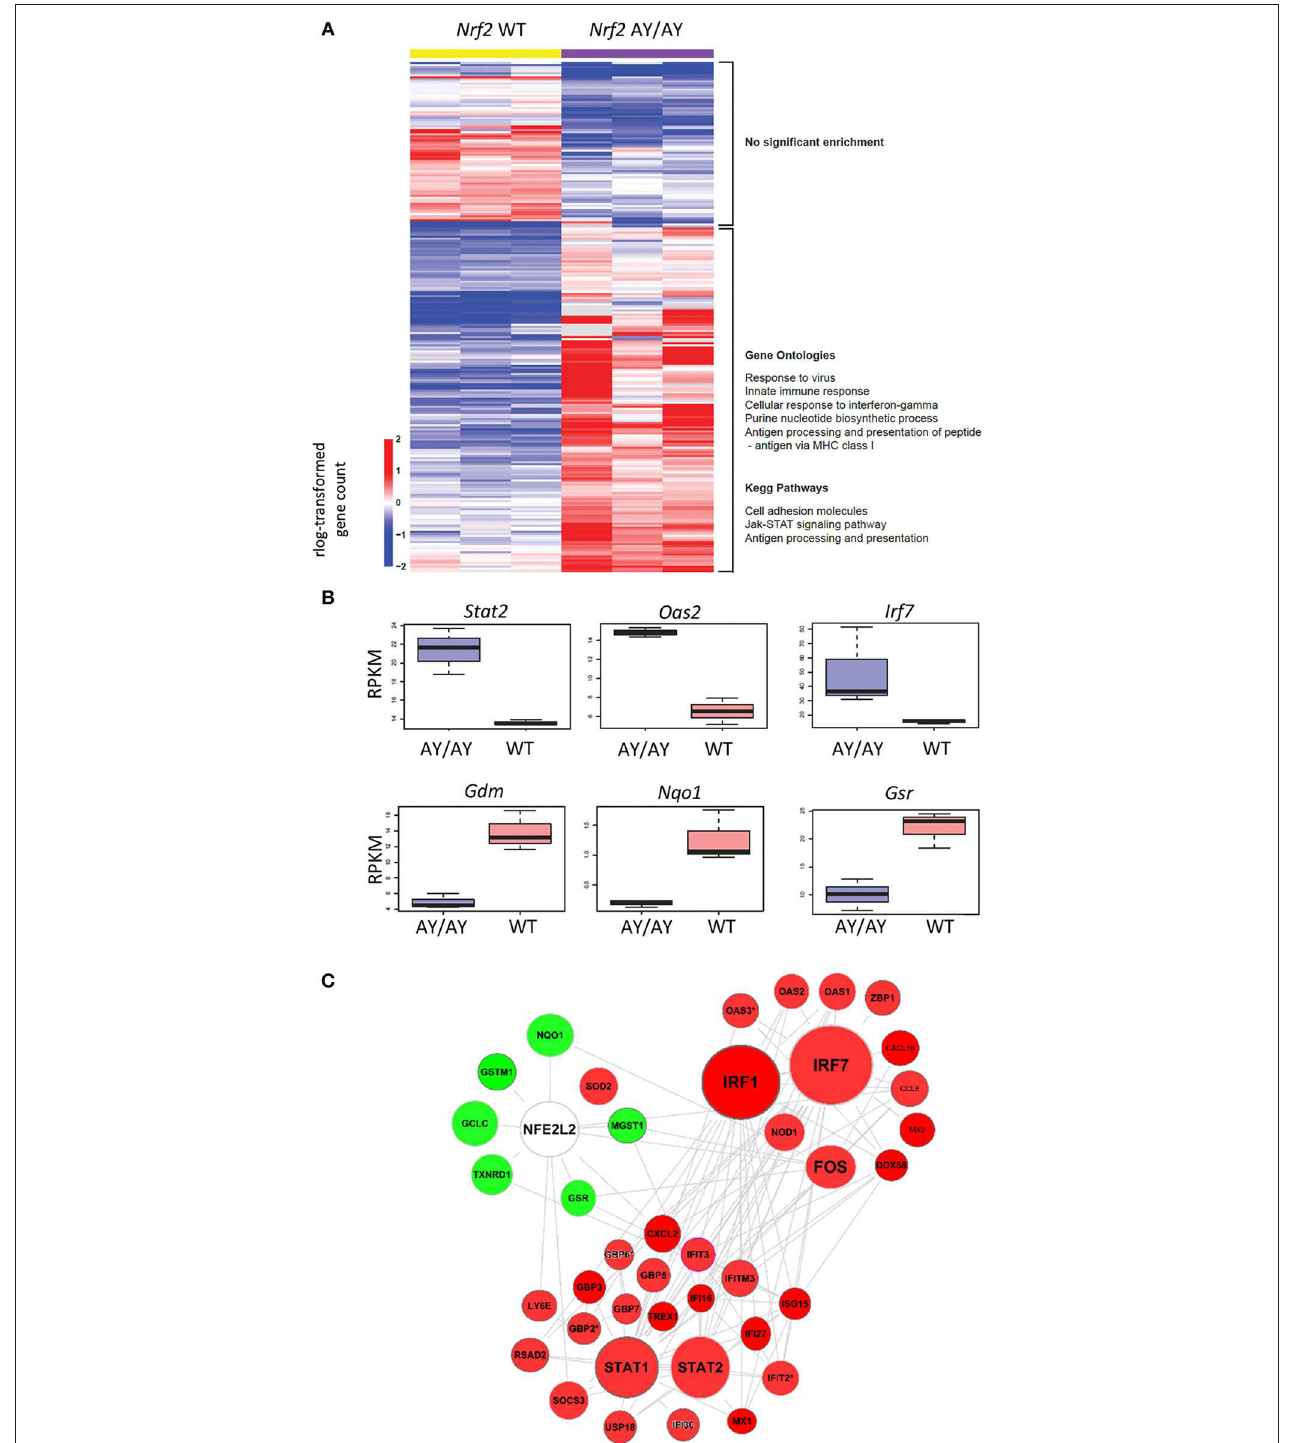
FIGURE 1 | Nrf2 alters the basal level of ISGs in murine macrophages. Comparison of antiviral gene expression profile by RNA-sequencing (RNAseq) analysis of wild-type (WT) and Nrf2 -mutated (AY/AY) bone marrow-derived macrophages (BMMs). Differentially expressed pathways and genes that satisfied p -value < 0.001 and fold change cutoff > 1 or < -1 were selected. The data are from one experiment performed in triplicate. (A) rlog-transformed gene counts and a listing of representative gene ontologies and KEGG pathways associated with these genes is represented in a heatmap. (B) Representation of RNA-reads for different interferon-driven and Nrf2-driven genes from RNAseq. Graph displays boxplots with boxes indicating mean, SEM as well as min and max values. (C) Cloud analysis of differentially expressed genes from Nrf2 AY/AY BMMs related to both Nrf2 and IFN-associated pathways is represented. The experiment is a re-analysis of the work of Otsuki et al. ( 33) (https://www.ncbi.nlm.nih.gov/pubmed/26677805).